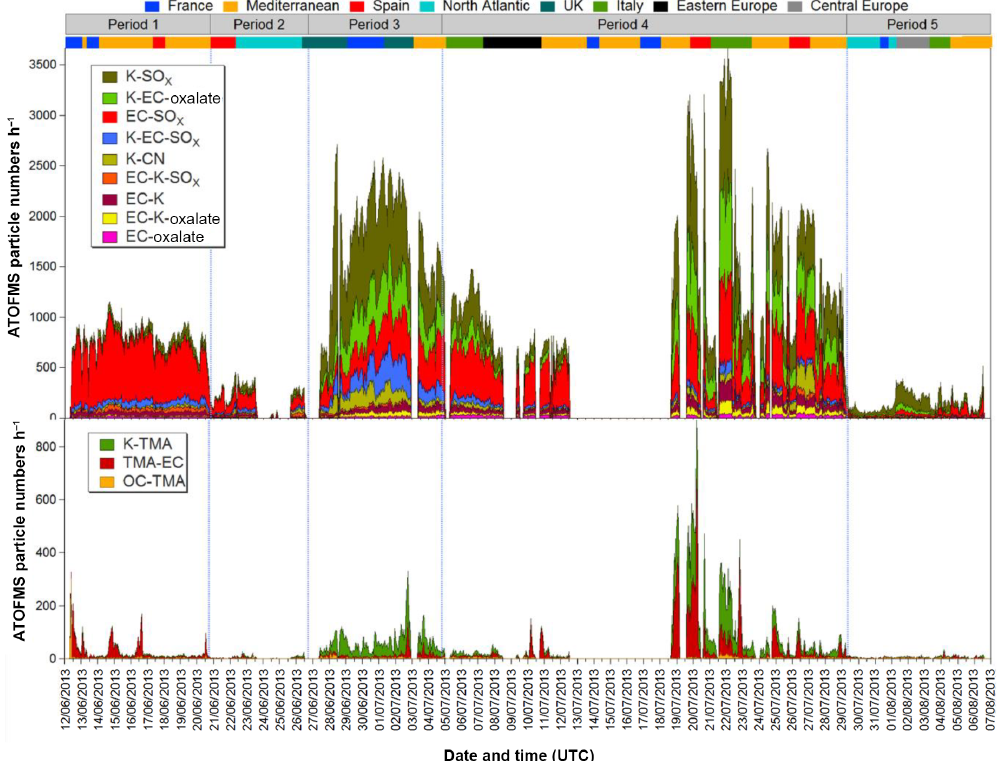
Figure 4. Time series (stacked) of hourly unscaled particle numbers for ATOFMS EC and major K-rich particle classes (top) and amine classes (bottom) observed during ADRIMED and SAF-MED. Dates are